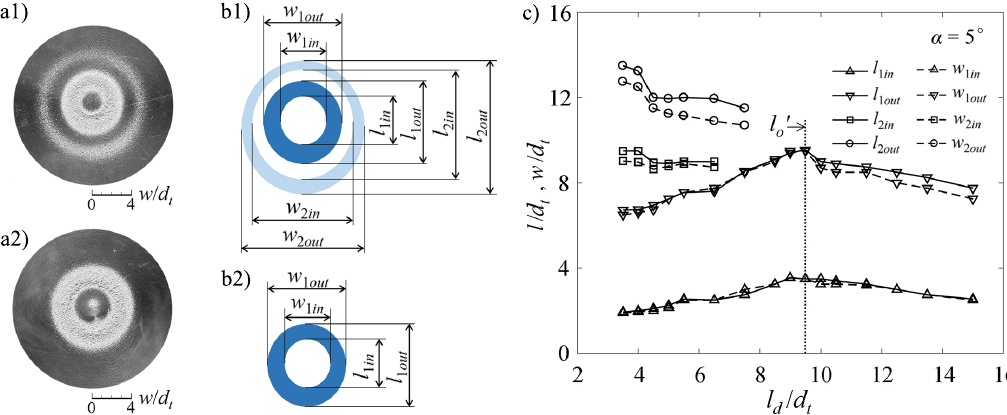
Figure 6. Normal view of eroded surface at α = 5 ◦ : ( a1 ) l d / d t = 5, ( a2 ) l d / d t = 10, ( b1 , b2 ) schematics of erosion area, ( c ) erosion distribution.